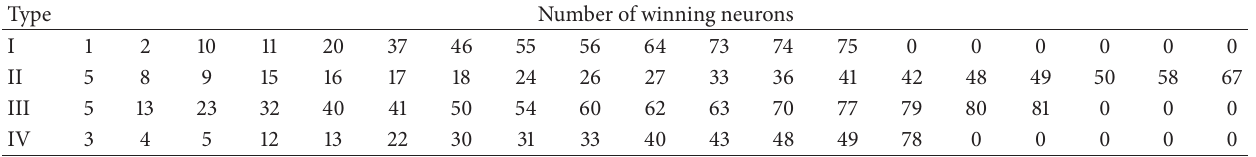
Table 5: Number of winning neurons corresponding to fault class of SOM neural network optimized by PSO algorithm.